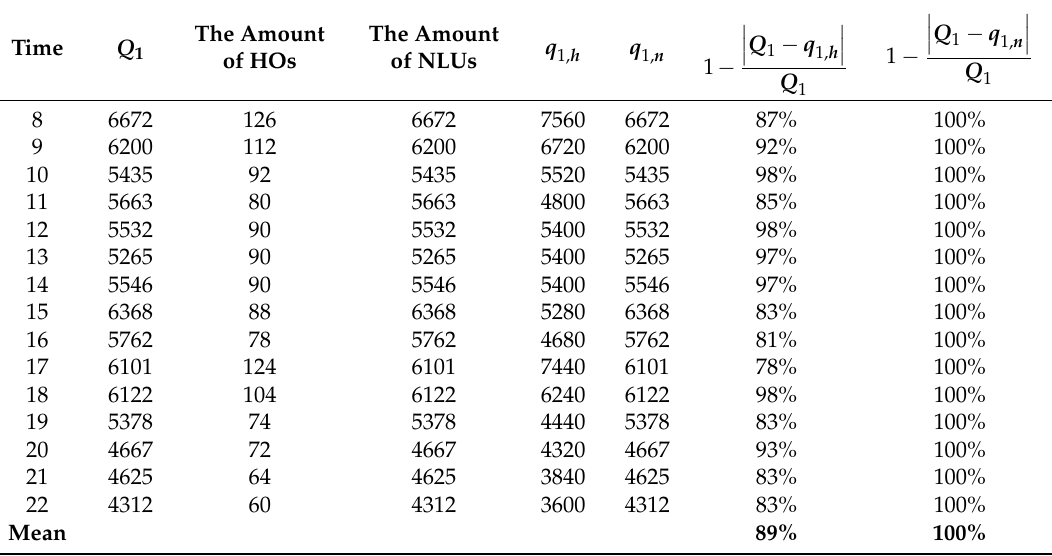
Table 2. The accuracies of traffic flow estimation of the road segment covered by Cell 1 .